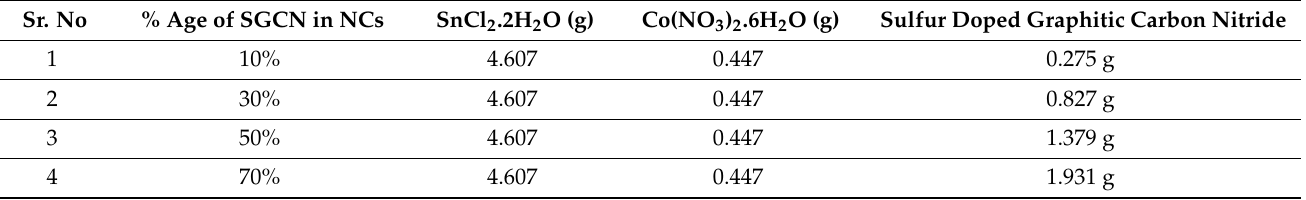
Table 2. Composition of Co-SnO 2 /SGCN